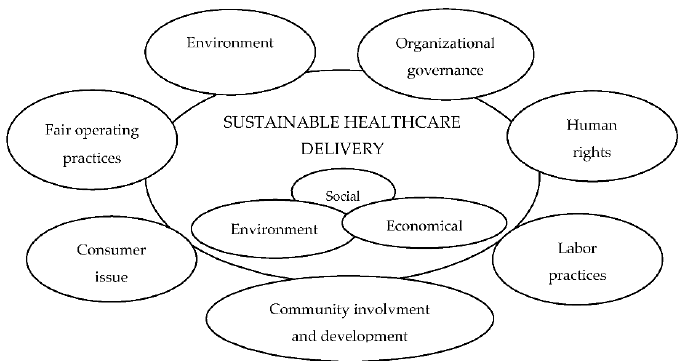
Figure 2. Pillars of sustainable development and ISO 26000 social responsibility core subjects.